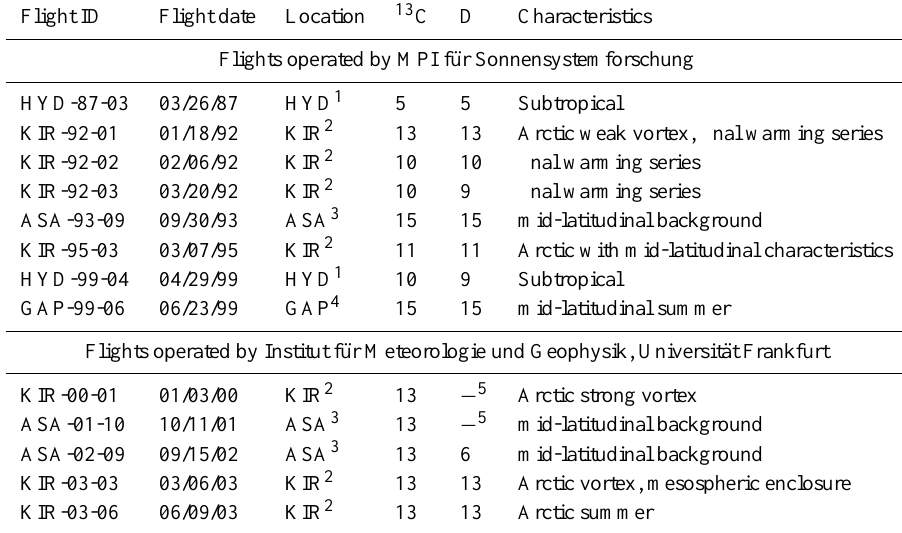
Table 2. Overview of balloon flights and number of samples analyzed for δ 13 C and δ D (column 13 C and D). Each flight is given a flight ID as STA-JJ-MM, where STA is the 3-letter-code for the balloon launch station, JJ the year and MM the month of